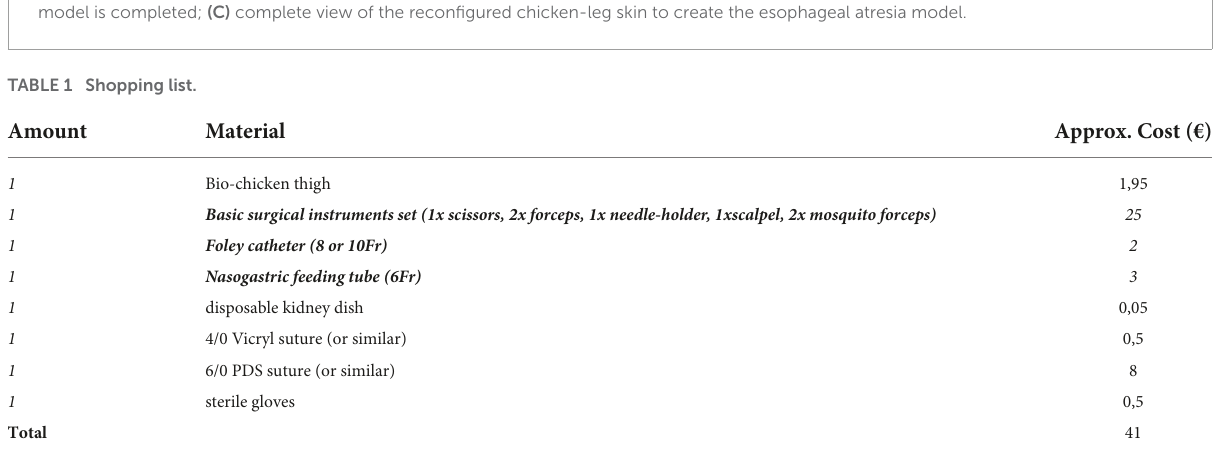
FIGURE1 Chicken-leg model: (A) shows the anatomical correlation of our model with a type C esophageal atresia; (B) shows the operative view once the model is completed; (C) complete view of the reconfigured chicken-leg skin to create the esophageal atresia